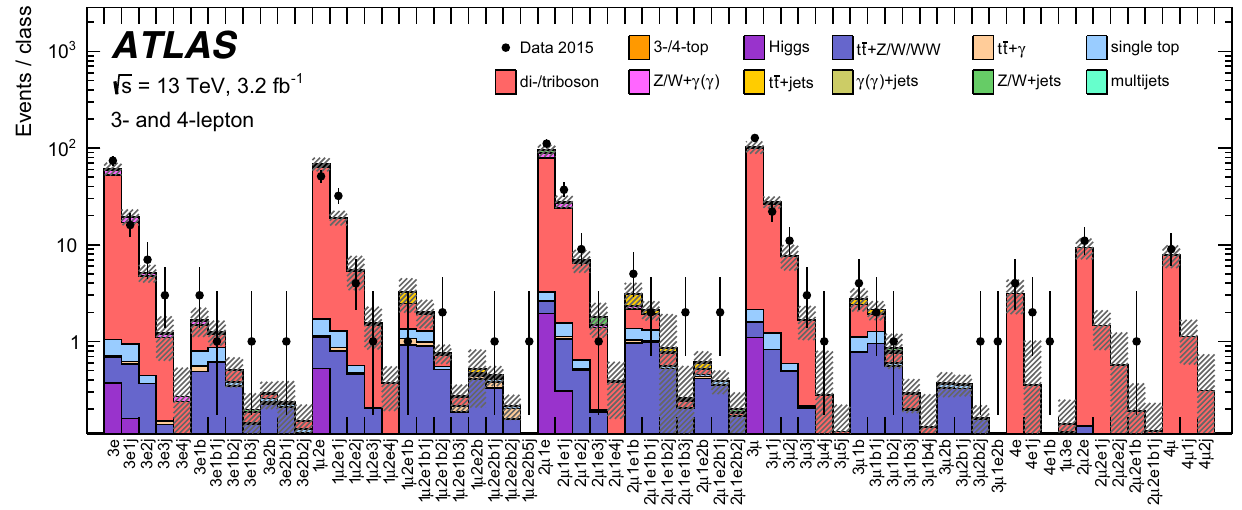
Fig. 16 The number of events in data, and for the different SM back- ground predictions considered, for classes with three or four leptons and ( b -)jets (no photons or E miss ). The classes are labelled according T